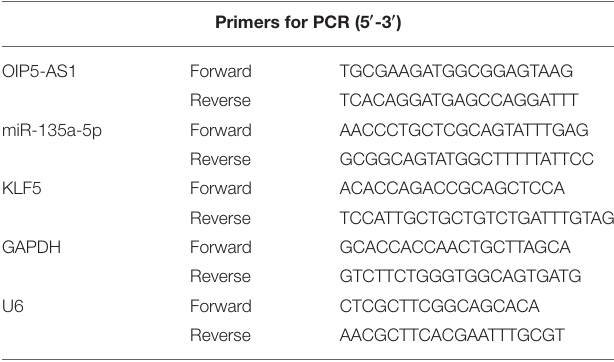
TABLE 2 | Primer sequences of